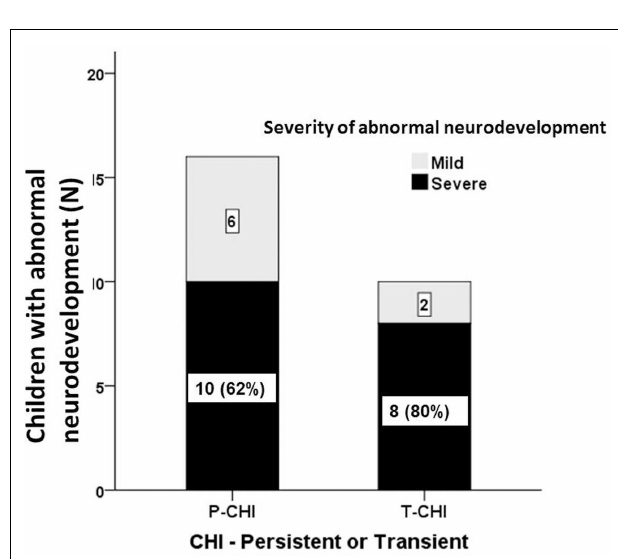
FIGURE 1 | Brain MR imaging in a 1-year-old girl with transient CHI, showing occipital lobe atrophy (OLA) and periventricular high signal intensities (PVHSI) in sagittalT2 FLAIR sequence scanning (1a) and